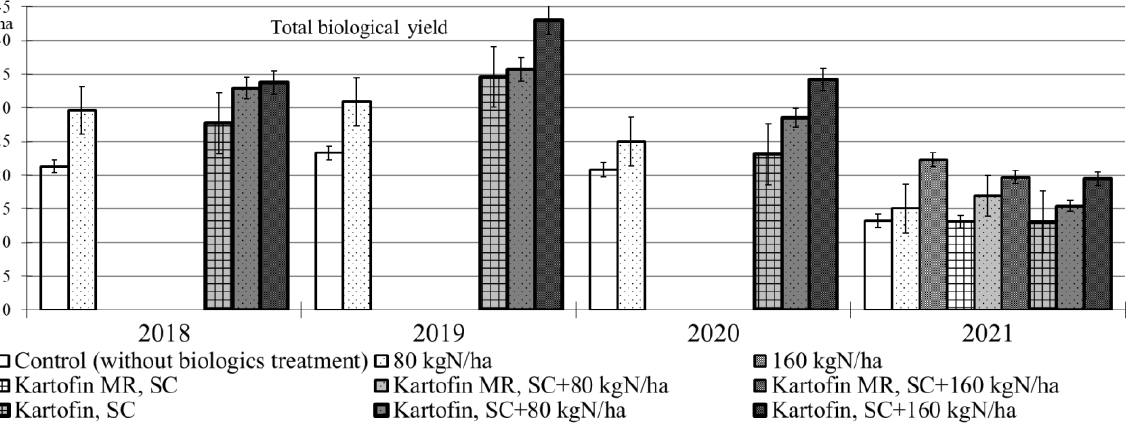
Figure 4. Effect of application polyfunctional biologicals (Kartofin, SC; Kartofin MR, C) and organic fertilizer BIAGUM in doses of 80 and 160 kg N ha − 1 on potato yield during its organic cultivating in 2018 – 2021 growing seasons.